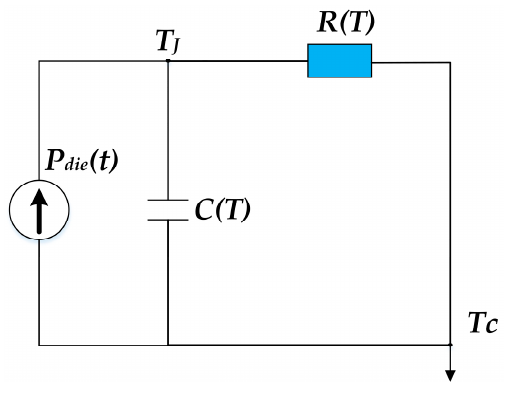
Figure 4. Single-layer Cauer-type thermal network.